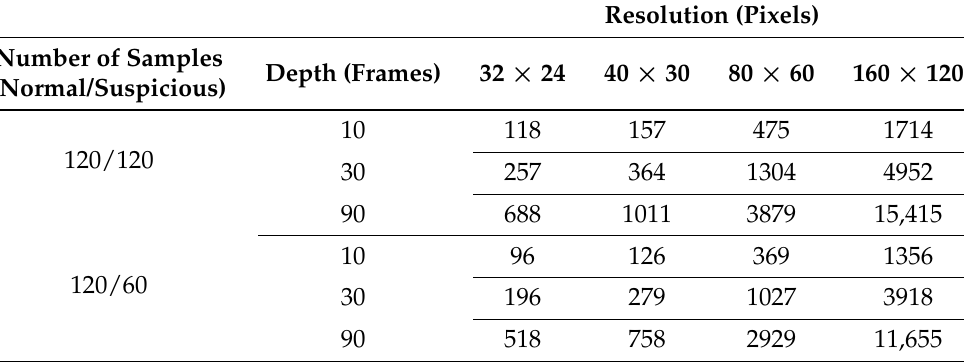
Table 10. Average training times in seconds comparison between different depths and